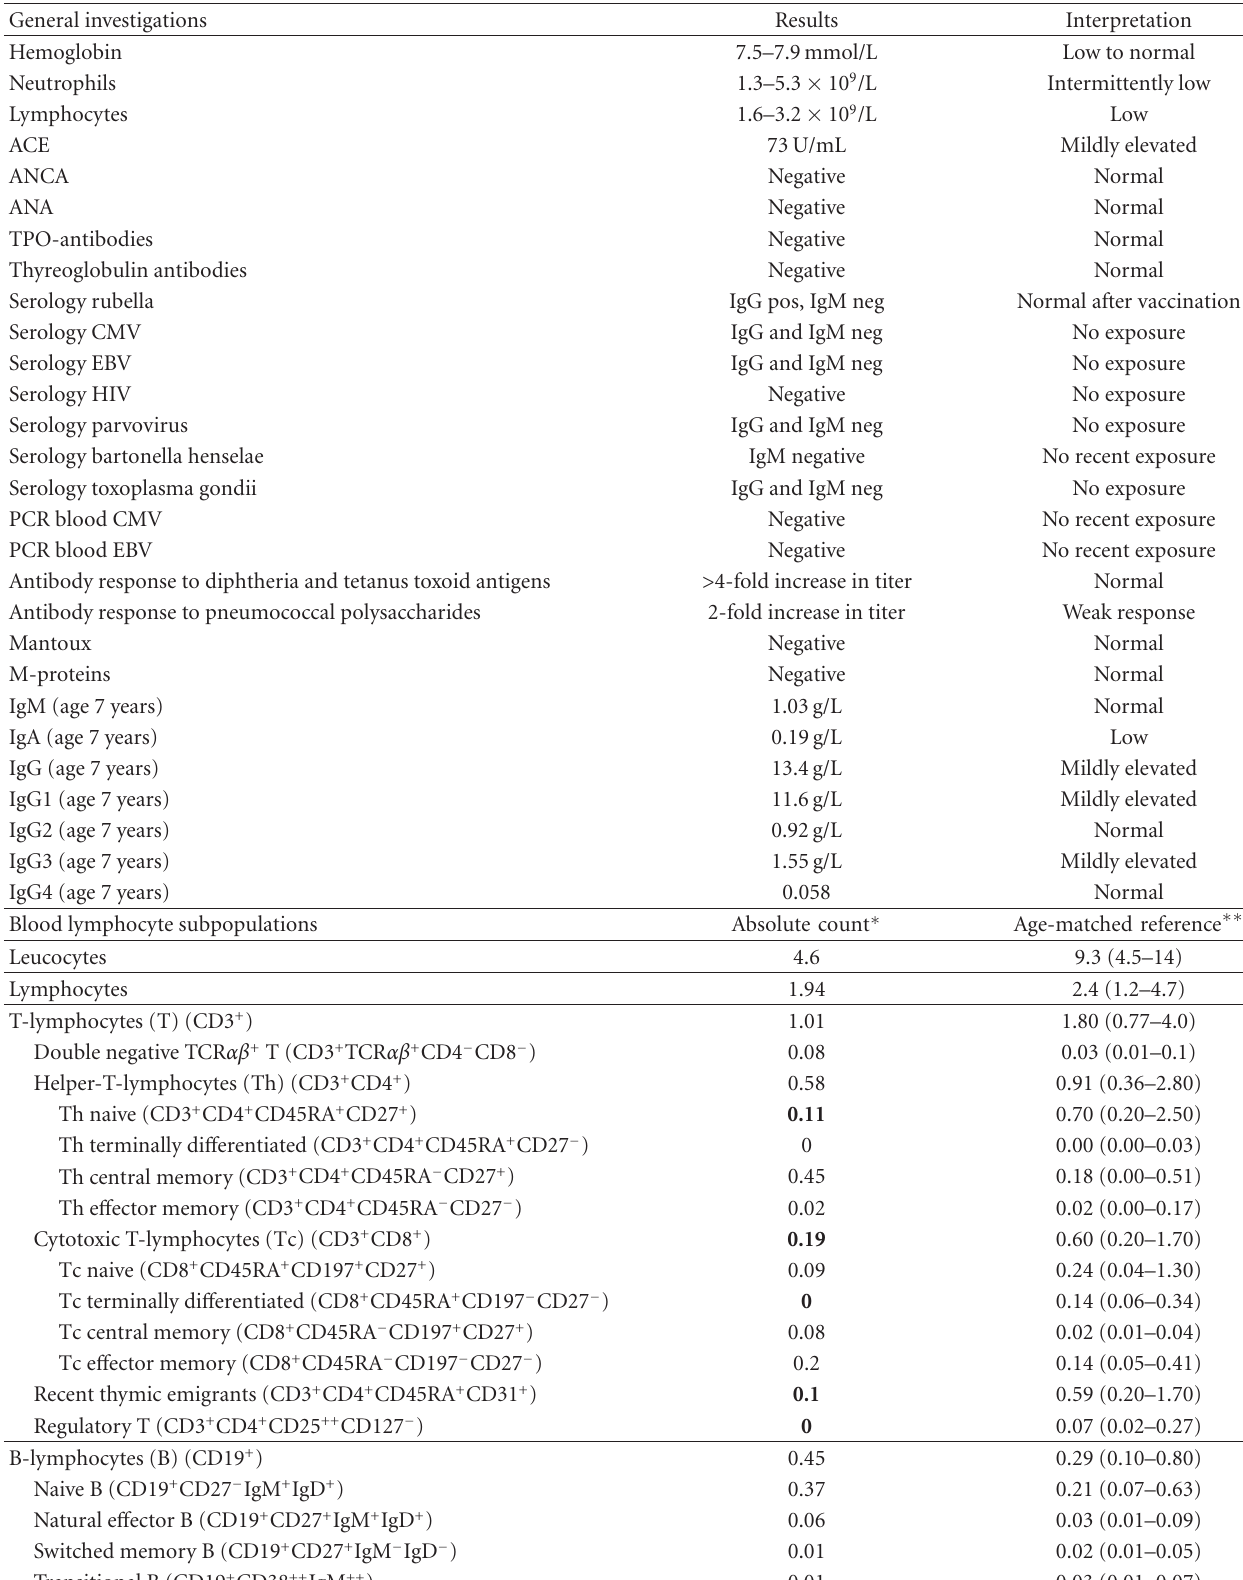
Table 1: Investigations in peripheral